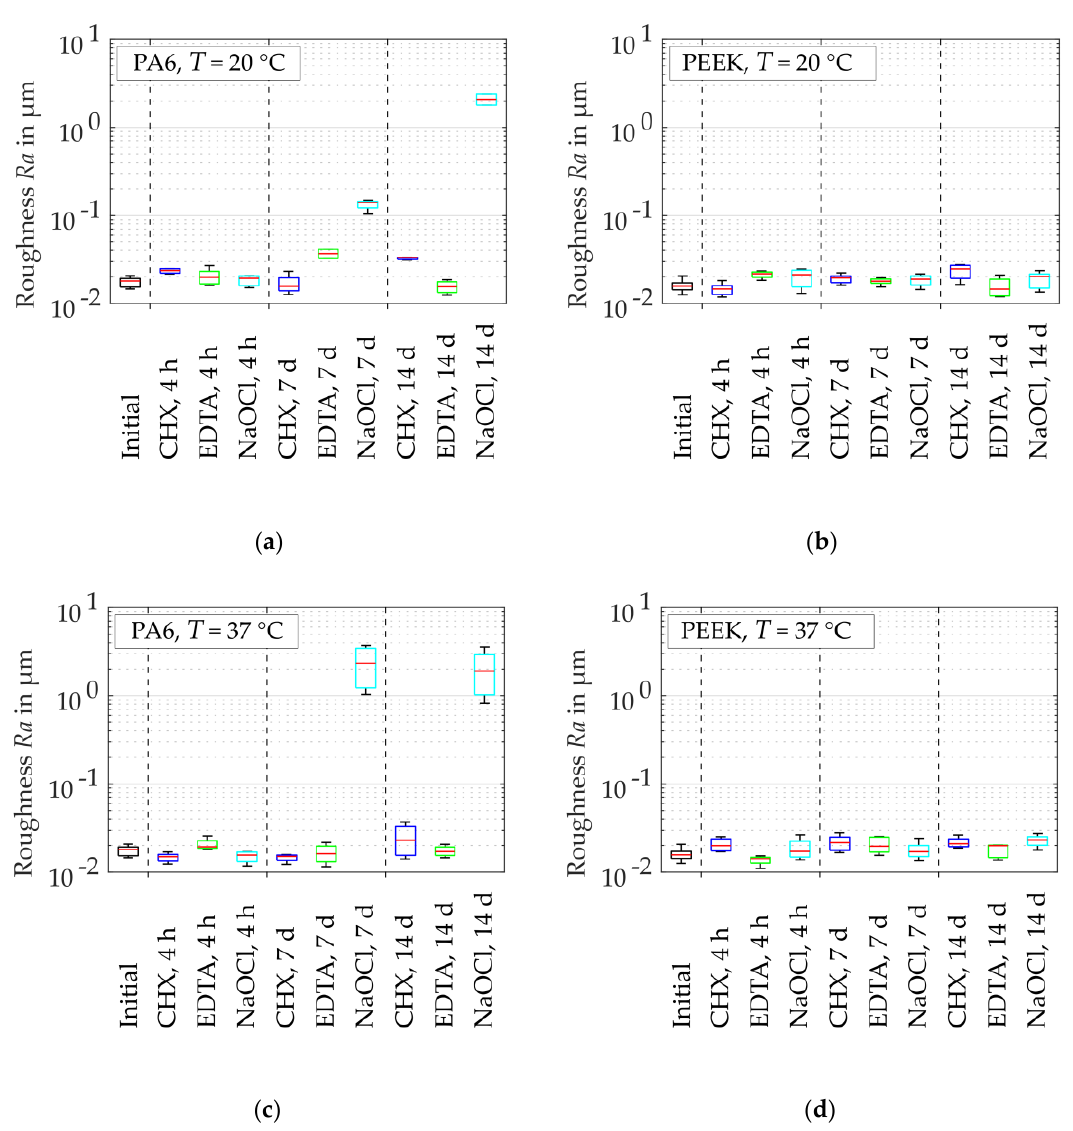
Figure 7. Alteration of surface roughness Ra (dried samples) due to absorption of irrigant after different storage times: ( a ) PA6 at T = 20 ◦ C; ( b ) PEEK at T = 20 ◦ C; ( c ) PA6 at T = 37 ◦ C and ultrasonic excitation; ( d ) PEEK at T = 37 ◦ C and ultrasonic excitation.